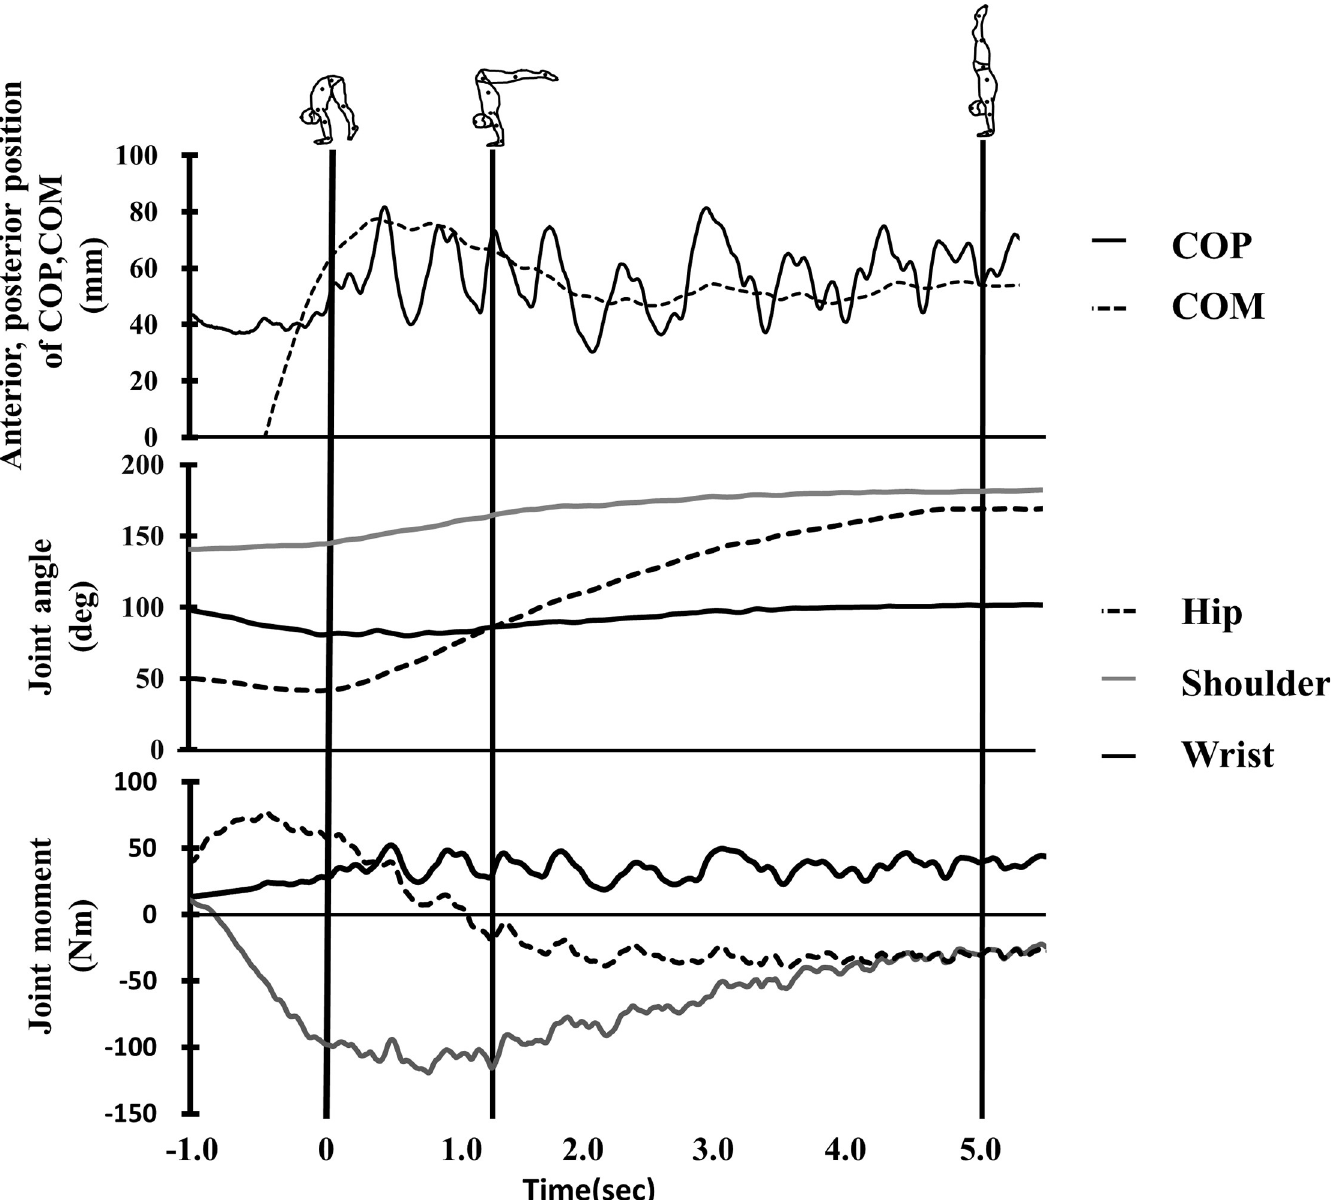
Fig 3. Typical examples of kinematics and kinetics during SAPH in a highly-skilled athlete. Origins of both COP and COM were set at styloid process of ulna’s y- coordinate. Vertical lines in the figure indicated respective three timings: Toe-off, Leg horizontal position and Handstand.